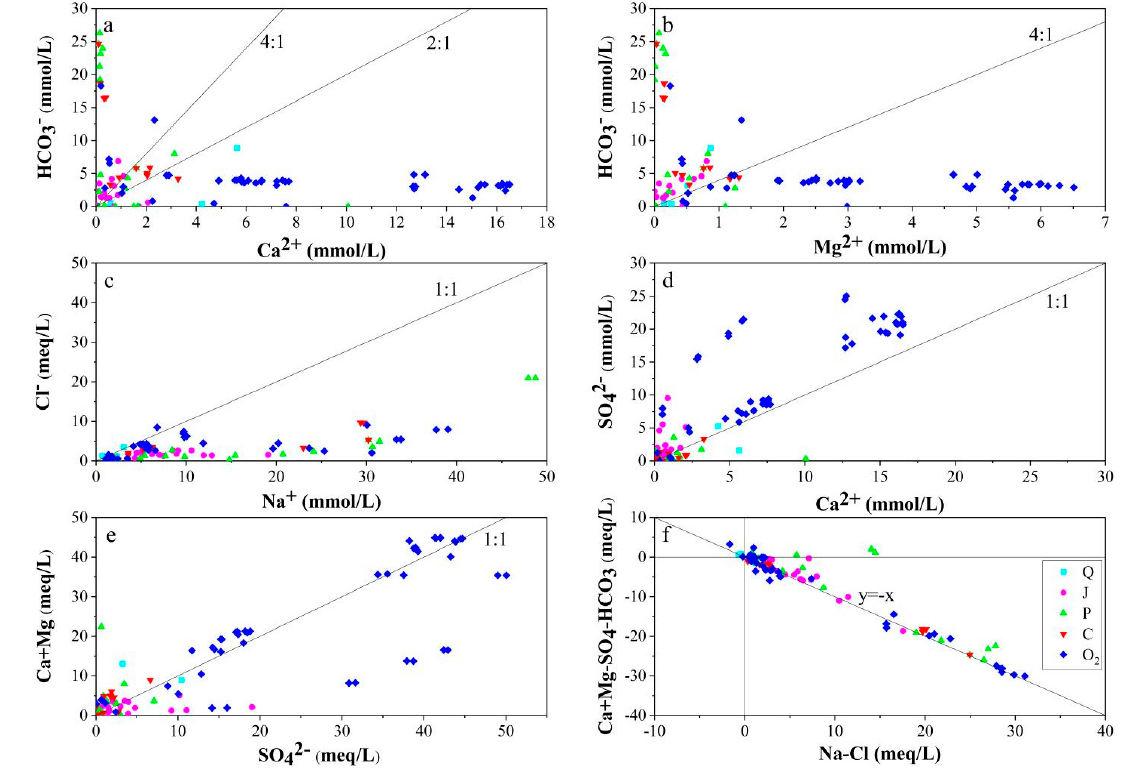
Figure 4. Relationship between ions: ( a ) Ca 2+ /HCO 3 − ; ( b ) Mg 2+ /HCO 3 − ; ( c ) Ca 2+ /SO 42 − ; ( d ) Na + /Cl − ; ( e ) (SO 4 )/(Ca+Mg); ( f ) (Na-Cl)/(Ca+Mg-SO 4 -HCO 3 ). Water 2022 , 14 , x FOR PEER REVIEW